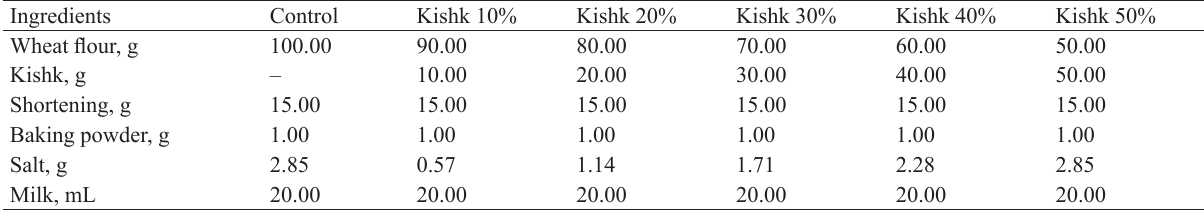
Table 1 Formulation of biscuit fortified with Egyptian kishk